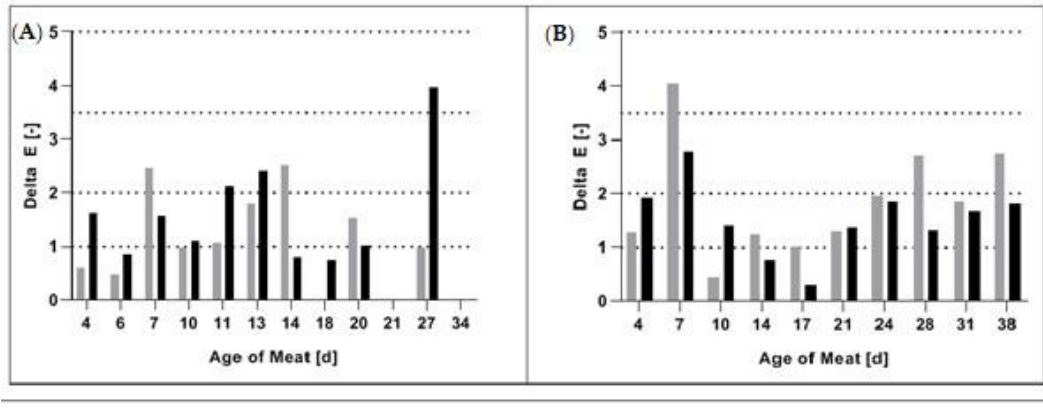
Figure A3. Average ( A ) L*-values (±S.D.), ( B ) a*-values (±S.D.), and ( C ) b*-values (±S.D.) in BioMAP and MAP in left-hand GM and right-hand PL over a meat age of 34 days and 52 days, respectively.